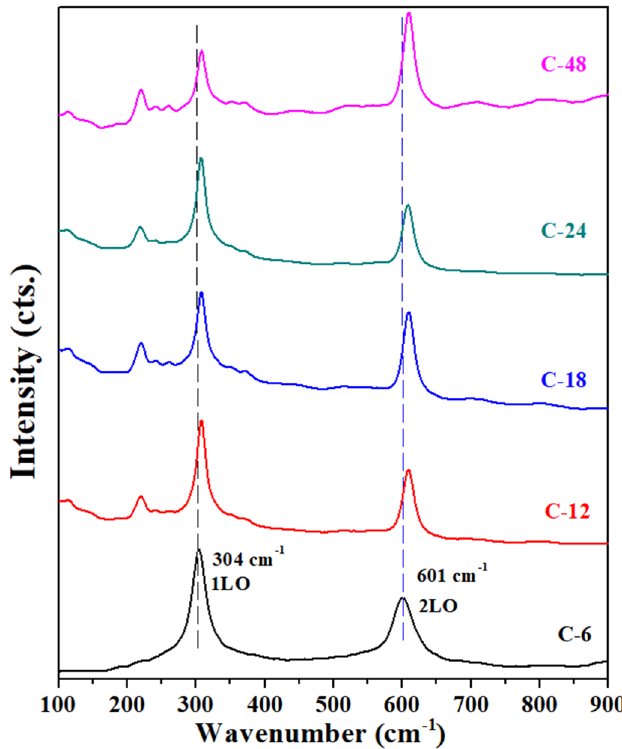
Figure 4. Raman spectra of CdS nanorods prepared at different reaction times.